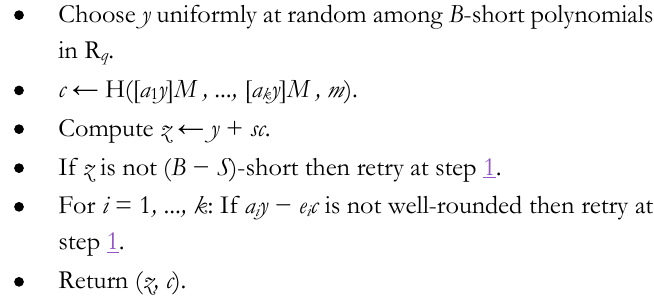
Algorithm 3 Informal description of the signature